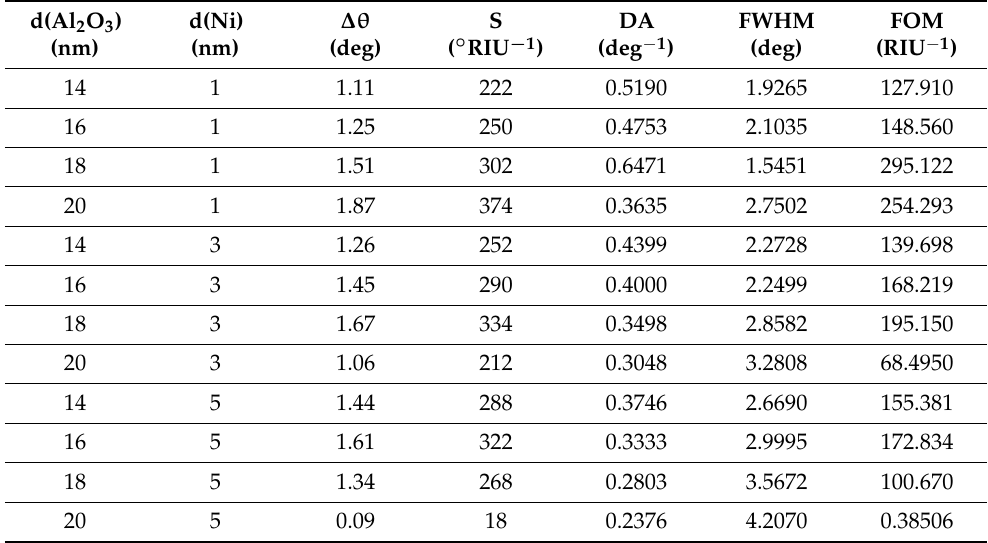
Table 4. The optimized thickness values of Al 2 O 3 and Ni with respect to the other parameters such as ∆ θ SPR , S, DA, FOM, and